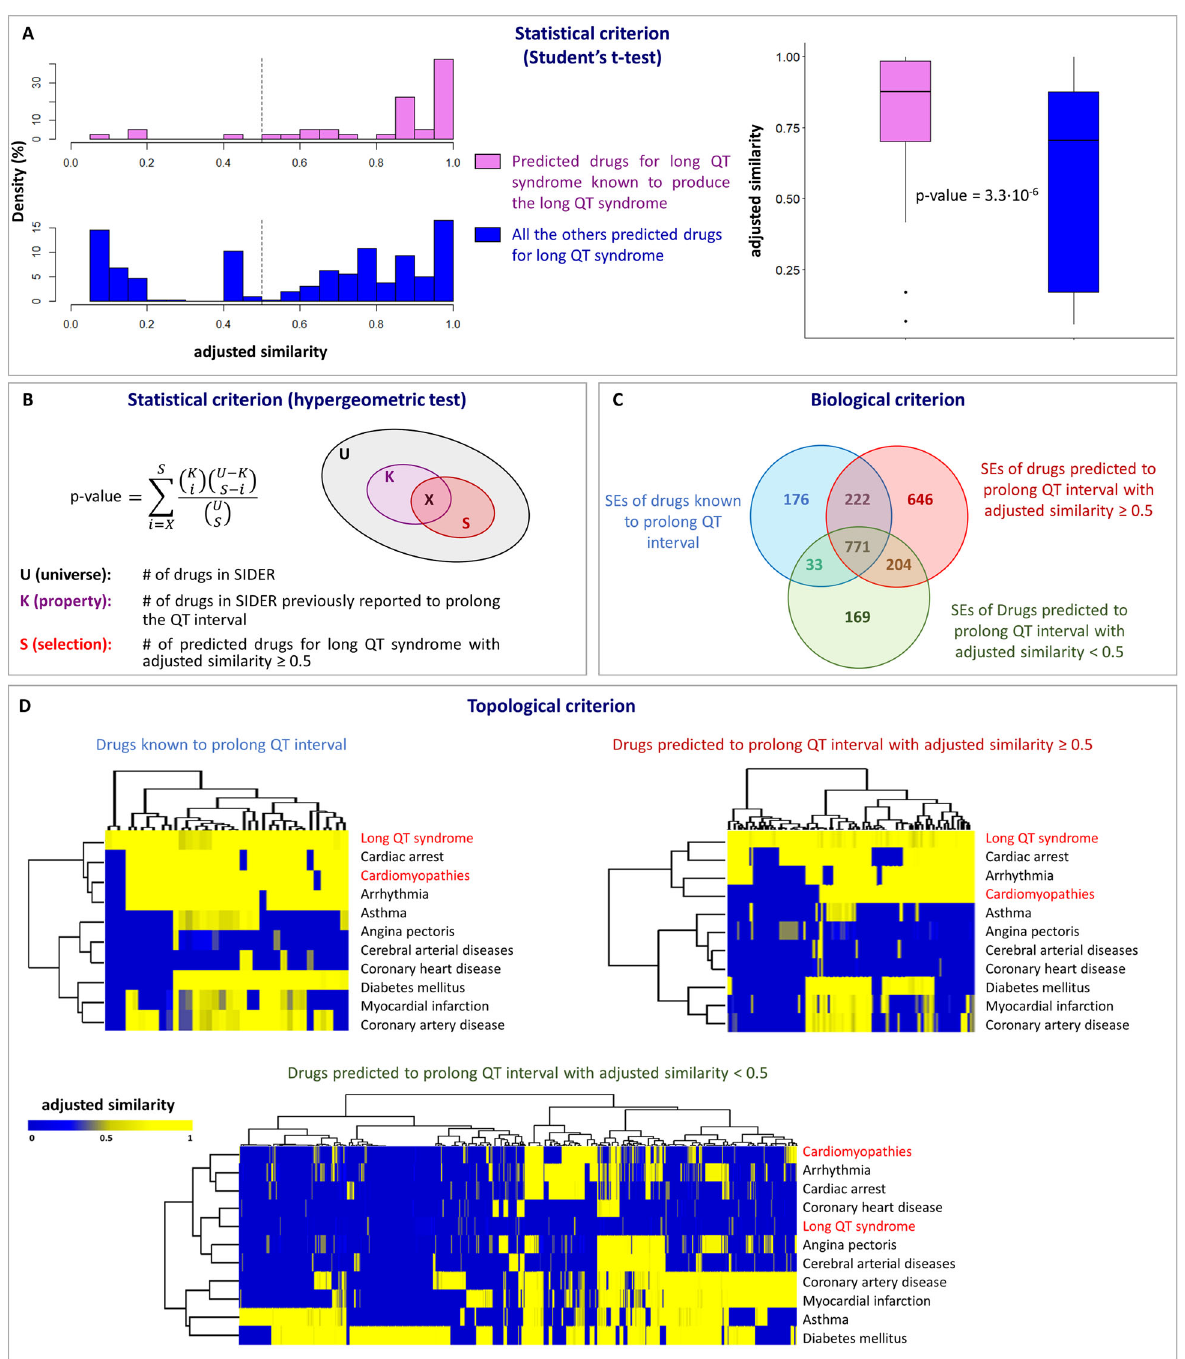
Fig. 4 Drug-side-effect proximity criterion. A Statistical criterion (Student ’ s t -test): histogram (left) and box plots (right) of the adjusted similarity values of the drugs predicted by SAveRUNNER as repurposable regarding their predicted effects on long QT syndrome, of the drugs known to induce long QT syndrome (pink bar), and of all the other predicted drugs (blue bar). t -test was used to compare the two distributions. Box-plot elements are so de fi ned: center line, median; box limits, upper and lower quartiles; points, outliers. B Statistical criterion (hypergeometric test): sketch of the ensembles considered for the hypergeometric test calculation. C Biological criterion: Venn diagram among the side-effects (SEs) of the drugs known to prolong QT interval (blue ensemble), of the drugs predicted by SAveRUNNER to prolong QT interval with adjusted similarity ≥ 0.5 (red ensemble) and with adjusted similarity <0.5 (green ensemble). D Topological criterion: dendrogram and heatmap of the drug-disease network predicted by SAveRUNNER including drugs known to prolong QT interval (top left), drugs predicted to prolong QT interval with adjusted similarity ≥ 0.5 (top right), and drugs predicted to prolong QT interval with adjusted similarity <0.5